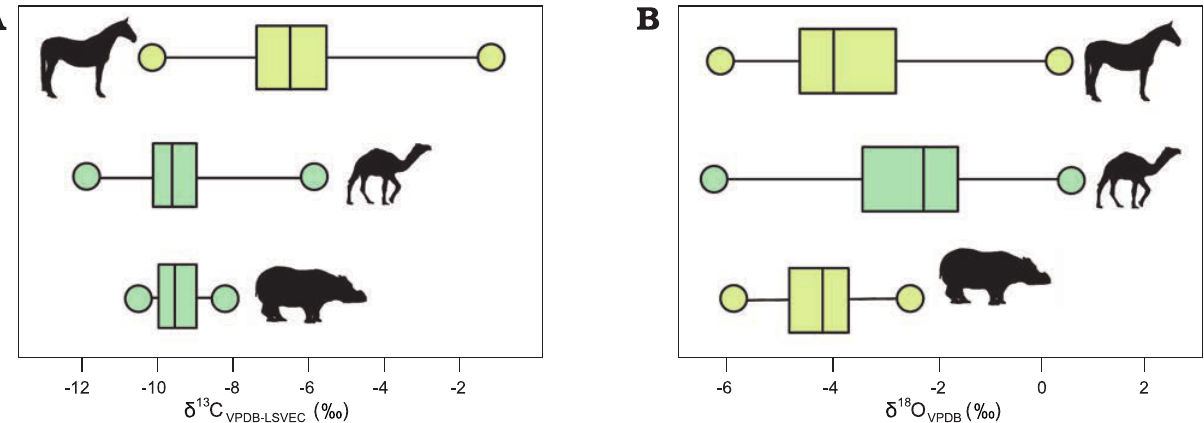
Fig. 2. Comparison of taxonomically­grouped stable isotope values for Optima Local Fauna (Miocene, late Hemphillian, Oklahoma, USA) horses (top), artiodactyls plus Mammut sp. (middle), and Teleoceras hicksi (bottom). Color differences indicate groupings that are statistically significantly different from one another. A . Average δ 13 C values. B . Average δ 18 O